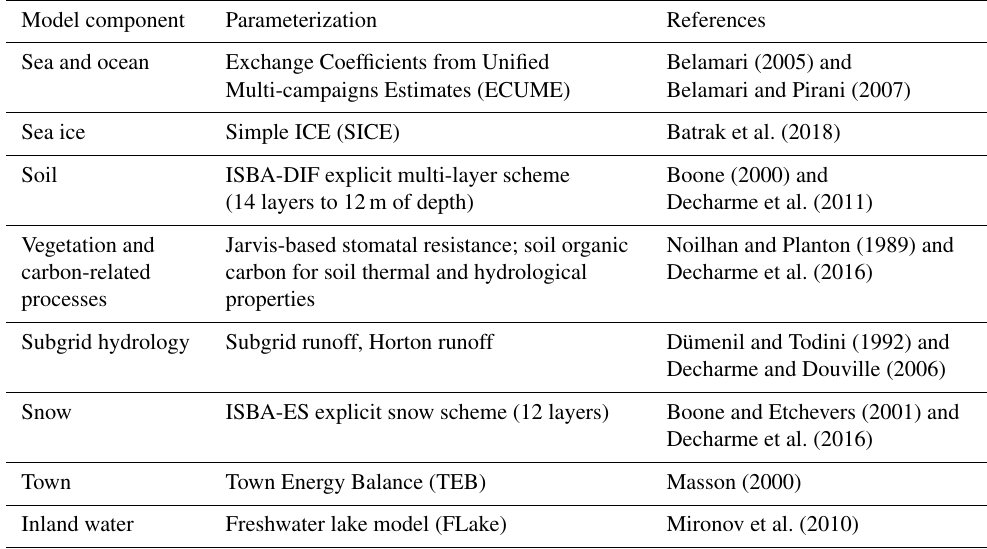
Table 2. SURFEX parameterizations used in